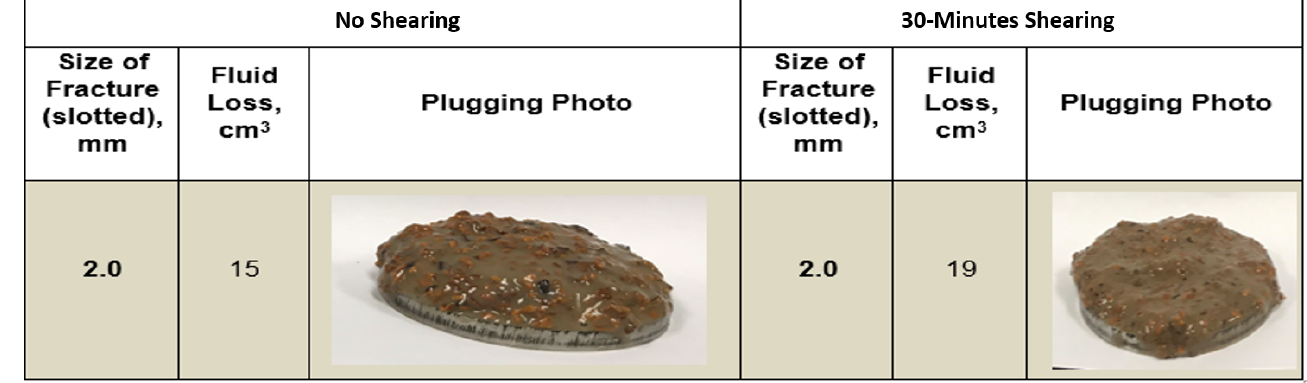
Figure 5. Walnut maximum plugged fracture diameter before and after shearing force.